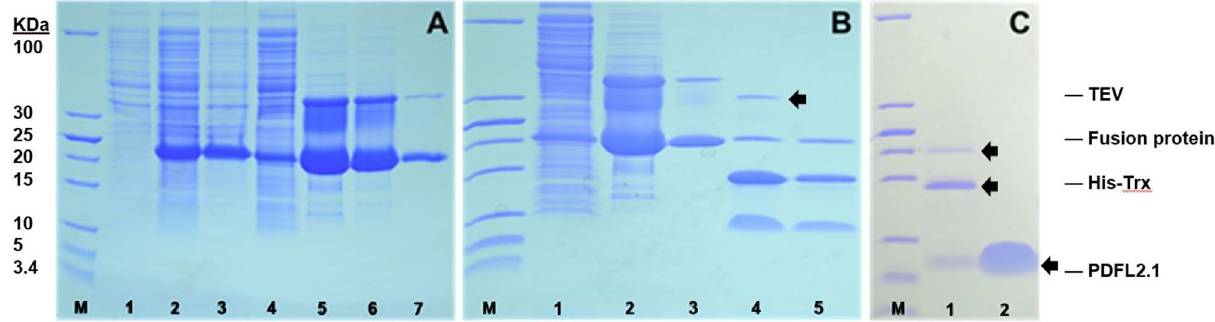
Figure 7. Purification of PDFL2.1. ( A ) His-tag purification of fusion protein. 1: Uninduced crude protein extract, 2: Induced crude protein extract, 3: Total soluble protein, 4: Insoluble fraction, 5–7: First, second and third elution after purification. ( B ) Digestion of the purified fusion protein with TEV protease. 1: Total soluble protein, 2: Eluted protein after His-tag purification, 3: Protein after acetone precipitation and dissolving in TEV reaction buffer, 4: TEV digested fusion protein, 5: Second His-tag purification after TEV digestion. ( C ) Final purification of PDFL2.1 using reverse phase chromatography. 1: TEV digested fusion protein, 2: Purified PDFL2.1 after chromatography. M: Low range protein ladder. Full-length gels are shown as Figure